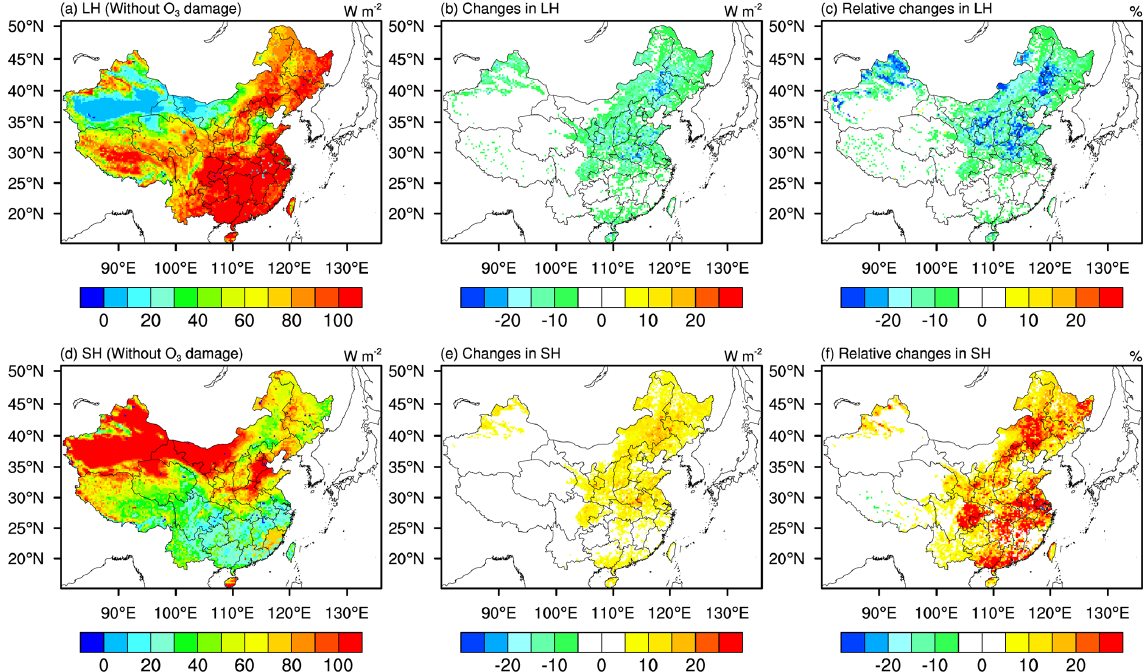
Figure 6. Spatial distribution of mean (a) latent heat flux (LH) and (d) sensitive heat flux (SH) from the simu_withoutO 3 experiment; absolute changes in (b) LH flux and (e) SH flux in JJA of 2014–2017 caused by O 3 damage; and relative changes in (c) LH flux and (f) SH flux caused by O 3 damage. Absolute changes are the LH (SH) flux from simu_withO 3 minus LH (SH) flux simu_withoutO 3 . Relative changes are calculated by absolute changes over LH (SH) flux from simu_withoutO 3